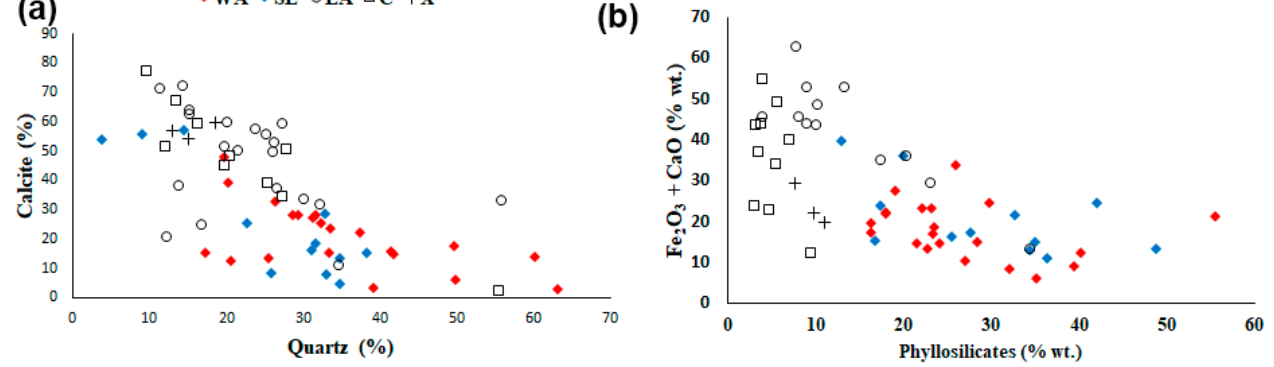
Figure 3. ( a ) Plots of quartz versus calcite content and ( b ) scatter diagram of Fe 2 O 3 + CaO vs. the % percentage weight of phyllosilicates.